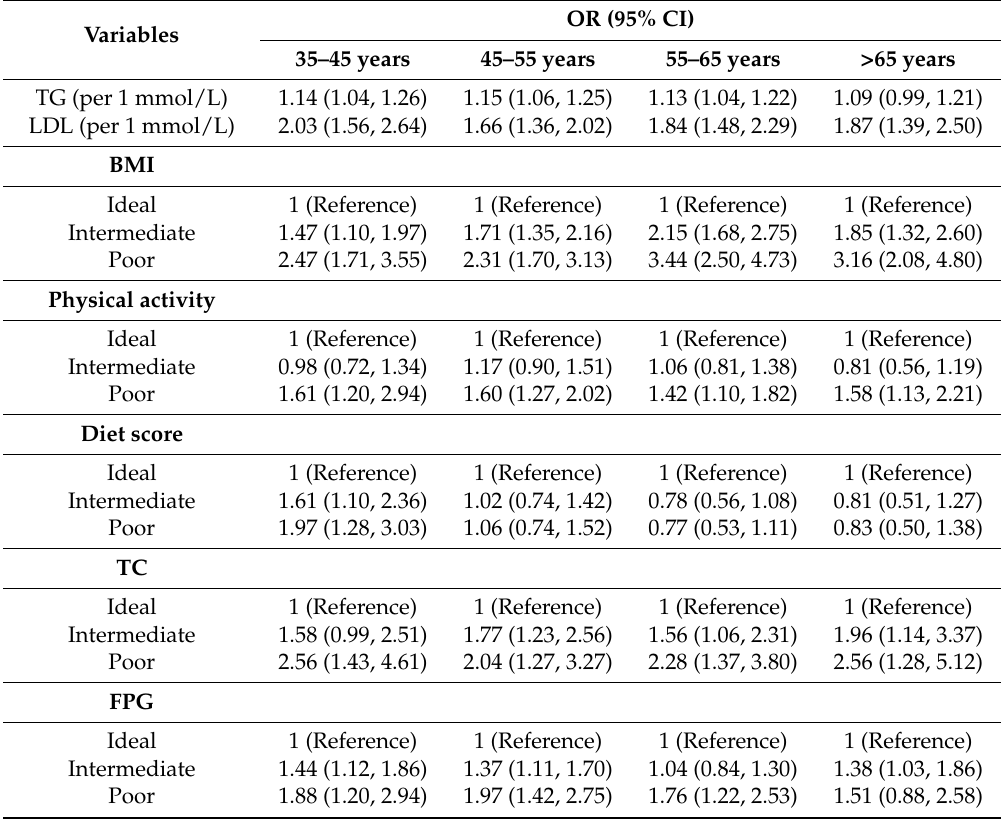
Table 4. Multiple logistic regression analysis of modifiable risk factors and the prevalence of hypertension accompanied by HHcy by age a